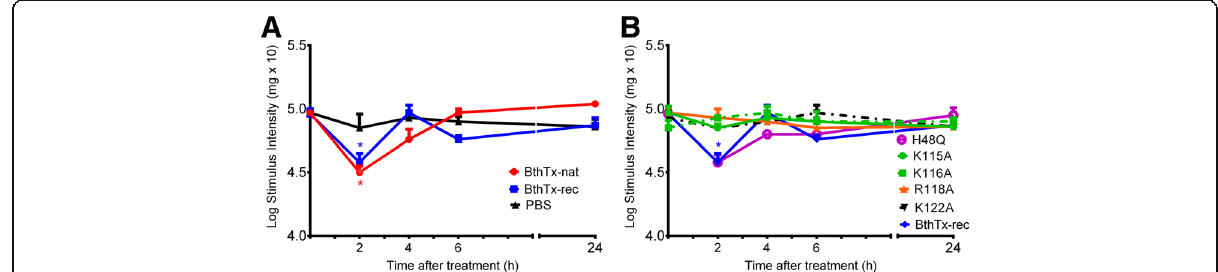
Fig 6 Characterization of allodynia induced by native and recombinant BthTx-I ( a ) and mutants BthTx-I ( b ). Decrease in tactile threshold was evaluated by von Frey test, before and 2, 4, 6 and 24 h after the intraplantar injection of PBS (control group), native, recombinant BthTx-I ( a ) or BthTx-I mutants ( b ). Sensitivity to pain was measured as the threshold response to tactile and expressed as g Log (mg × 10). Each point represents the mean ± SEM of six animals. *Significantly different from mean values before venom injection ( p <